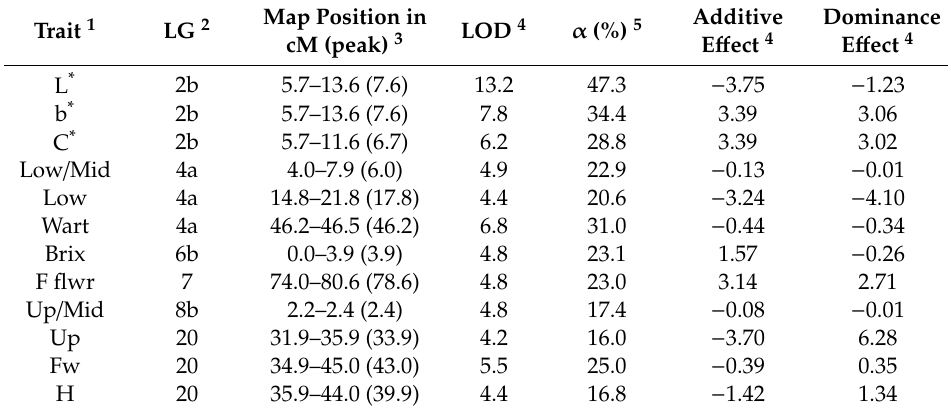
Table 2. Quantitative trait loci (QTLs) for flowering and fruit traits detected in the F 2 plants derived from a cross between ‘TN 6’ and ‘Shishigatani’-K.